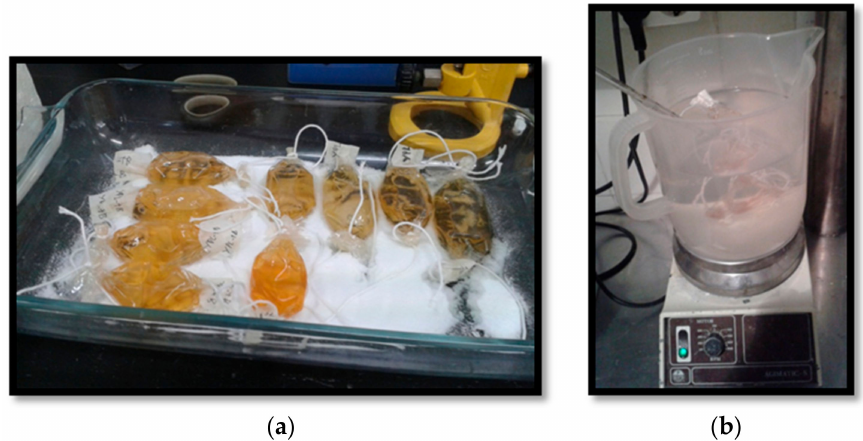
Figure 5. Dialysis process prior to lyophilization to obtain the enzymatic extracts. ( a ) Preparation of the samples for dialysis, with the membranes in characteristic cylindrical form; ( b ) Wash with phosphate buffer dissolution of the dialysis